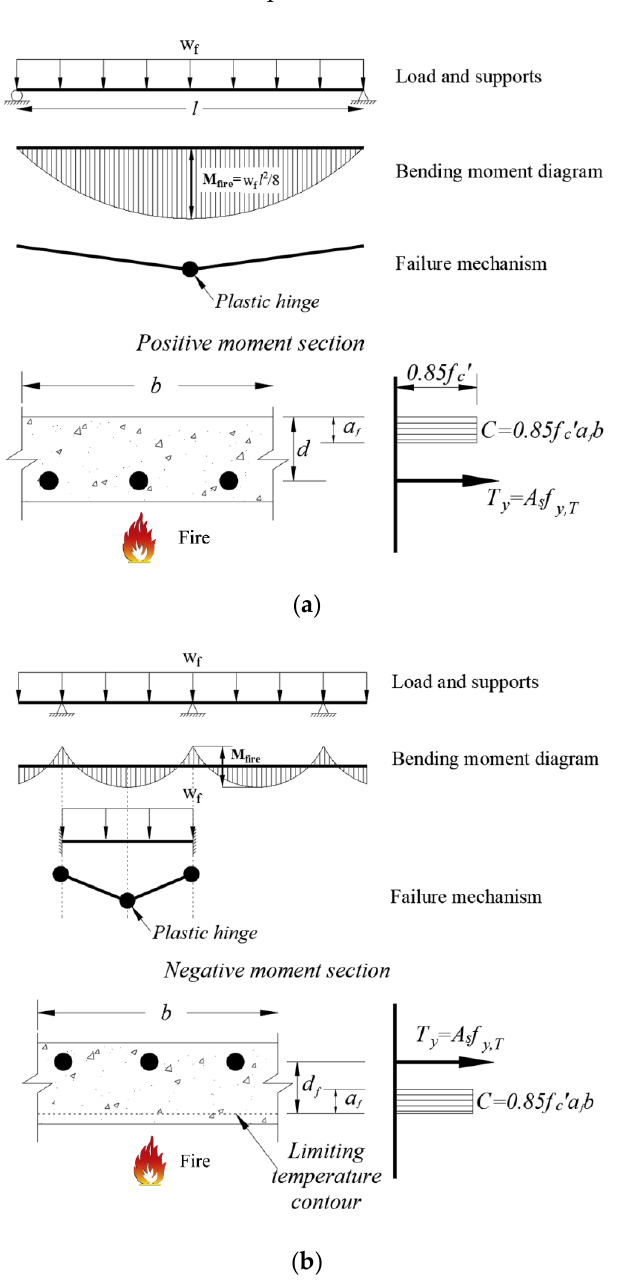
Figure 1. Failure mechanism and equivalent compressive stress block of reinforced concrete (RC) slab exposed to fire: ( a ) Simply supported; ( b ) continuously supported.